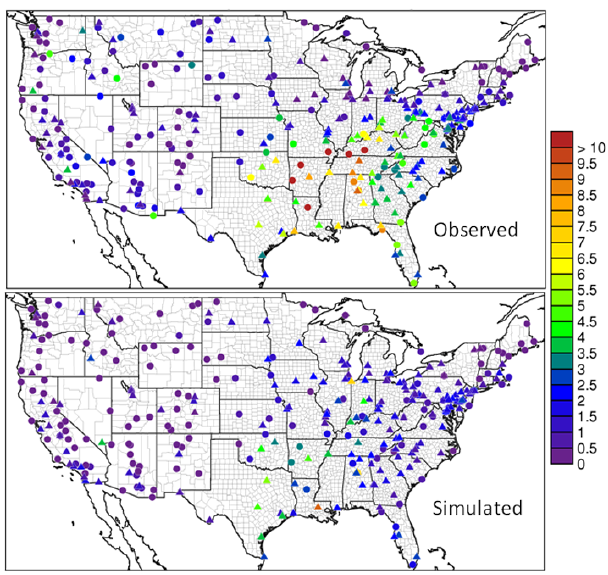
Fig. 6. Observed (top) and CMAQ simulated (bottom) average fine particulate soil concentrations (µgm − 3 ) as estimated by the IM- PROVE soil equation for 13 July, 28 July, and 4 August 2006. IM- PROVE sites are indicated by circles; CSN sites are indicated by